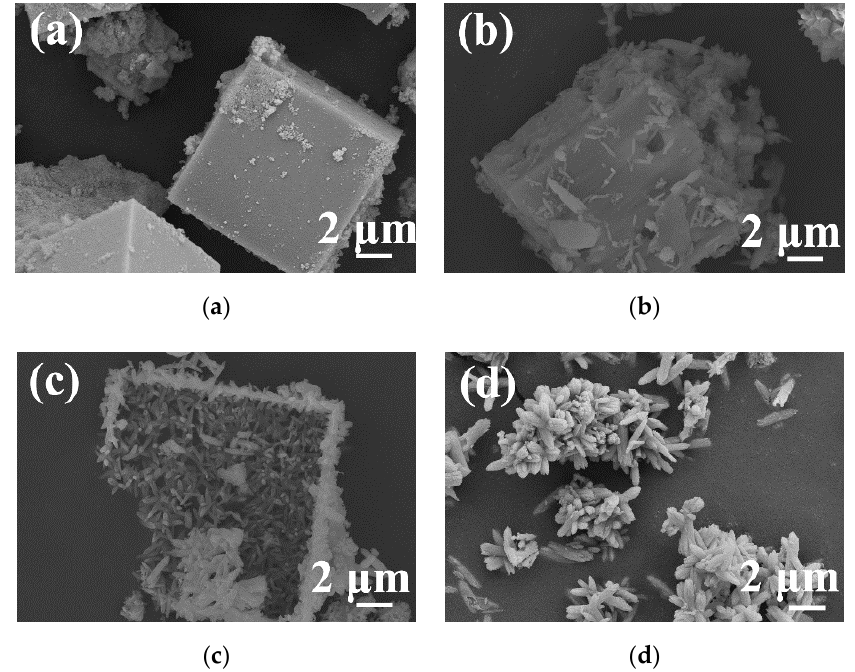
Figure 3. SEM images of hydrothermal products obtained with different stirring times: ( a ) 0 min; ( b ) 10 min; ( c ) 20 min; ( d ) 30 min.